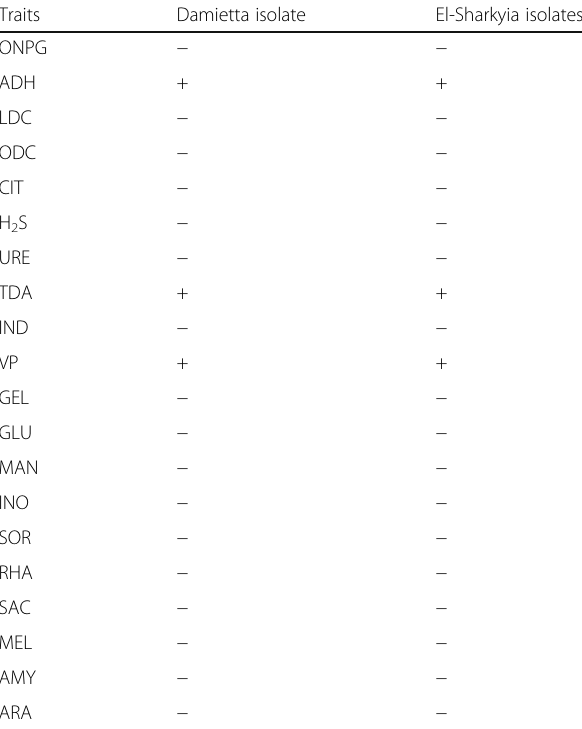
Table 3 Sugar utilization of Bacillus thuringensis isolates using the API 20E system